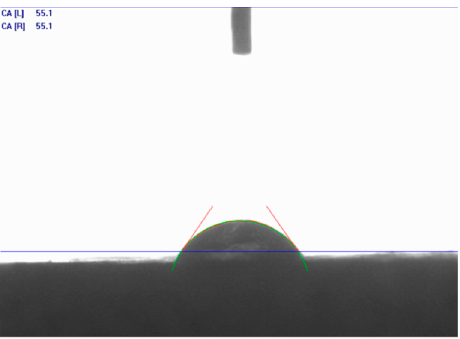
Figure 14. Contact angle for DW (distilled water) and Indiana limestone (55.1°).